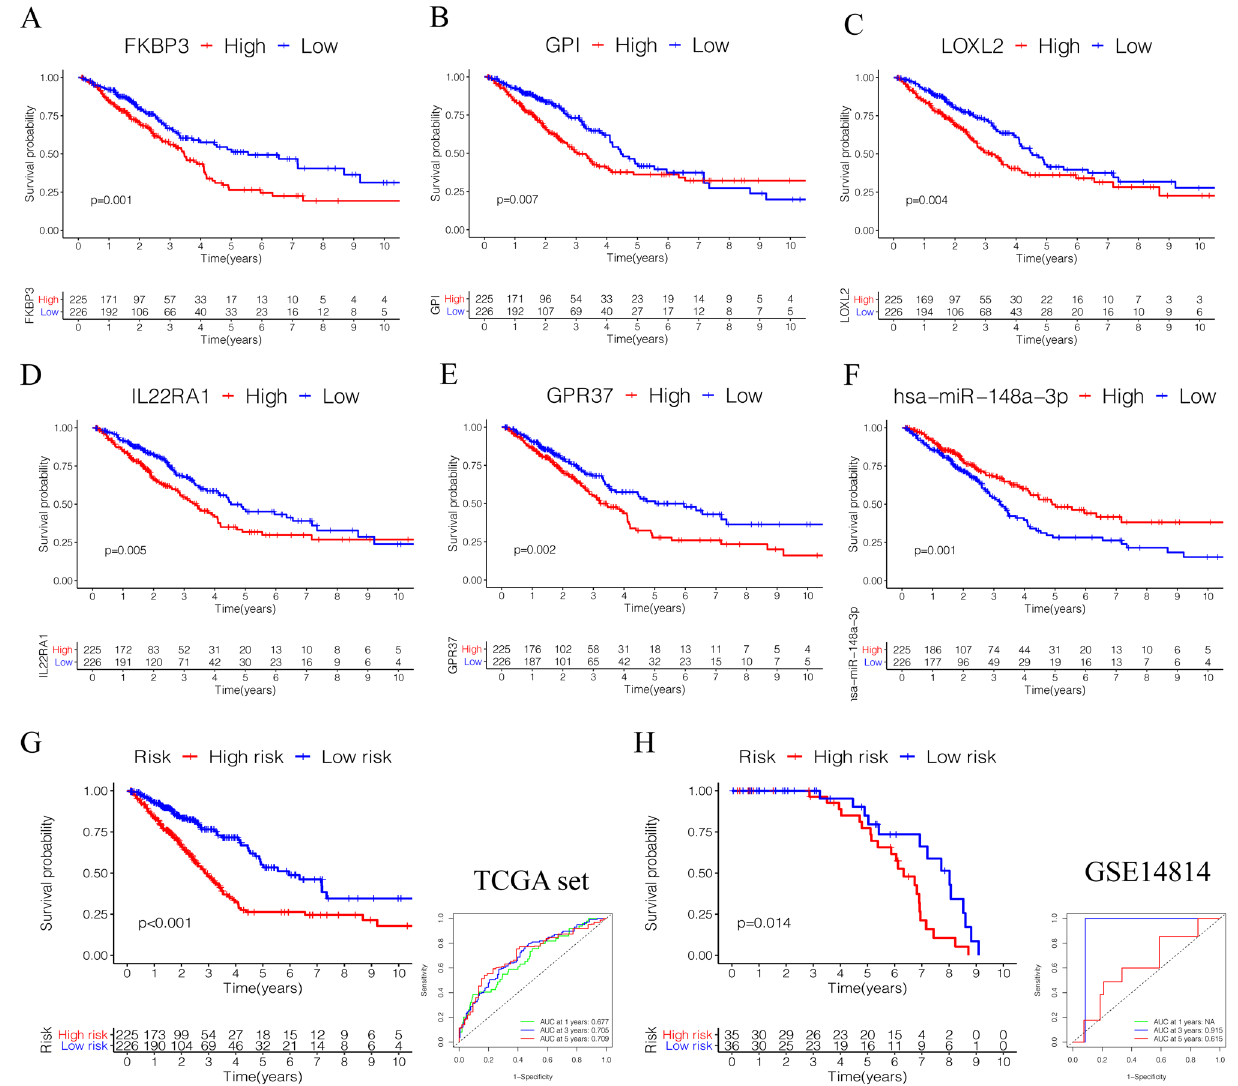
Figure 4. Survival analysis of prognostic genes in ceRNA network. ( A – F ) The Kaplan–Meier curves validated the 6 key genes ( FKBP3, GPI, LOXL2, IL22RA1, GPR37 , has-miR-148a-3p ) were significantly associated with overall survival, p -value < 0.05. ( G ) The Kaplan–Meier overall survival curves for risk score groups. Red curves represent high risk group and blue curves represent low risk group, p -value < 0.05. ( H ) The ROC curves showed that the area under curve (AUC) at 1 year was 0.677, at 3 year was 0.705, and at 5 years was